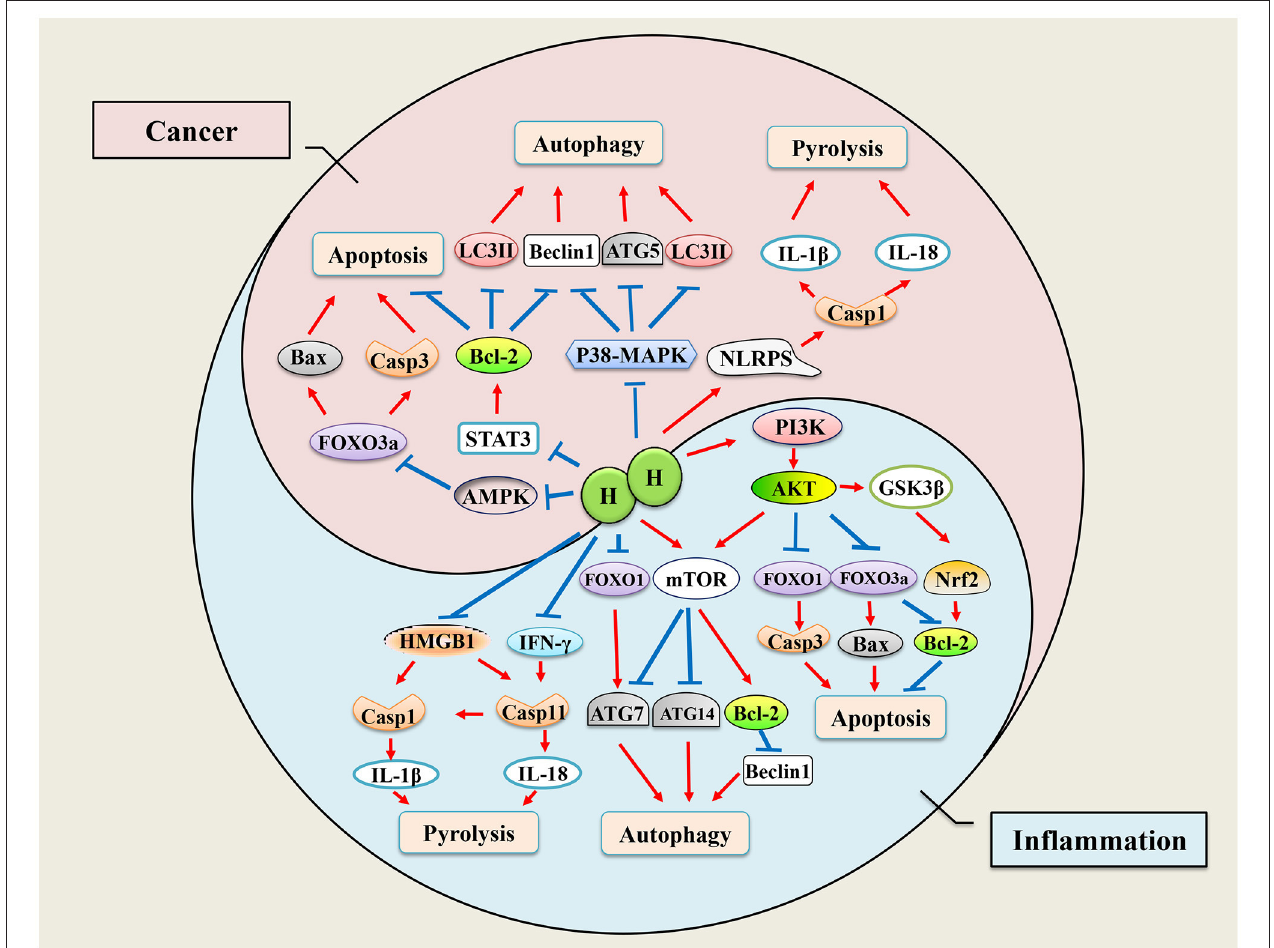
FIGURE 1 | Mechanisms of hydrogen regulates cell death. Hydrogen has bidirectional regulatory effects on apoptosis, autophagy, and pyrolysis. When inflammation occurs, cells initiate apoptosis, autophagy, and pyroptosis to adapt to environmental changes, while hydrogen therapy ameliorates inflammation-induced excessive cell programmed death by regulating transcription of genes. When tumor occurs, hydrogen plays an antitumor role by promoting cell apoptosis, autophagy, and pyrolysis.